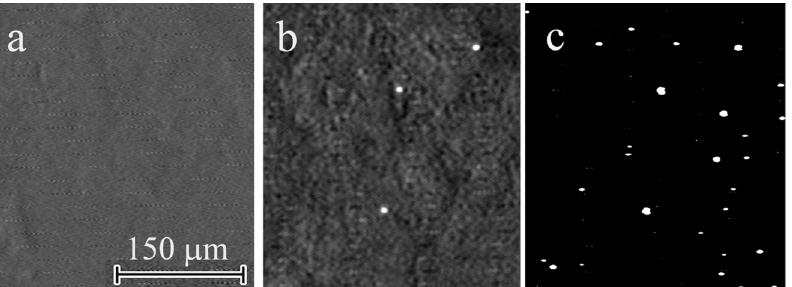
Figure 1. The EBIC images of the selected region at E b = 10 keV obtained before ( a ) and after applying − 8 ( b ) and − 15 V ( c ).